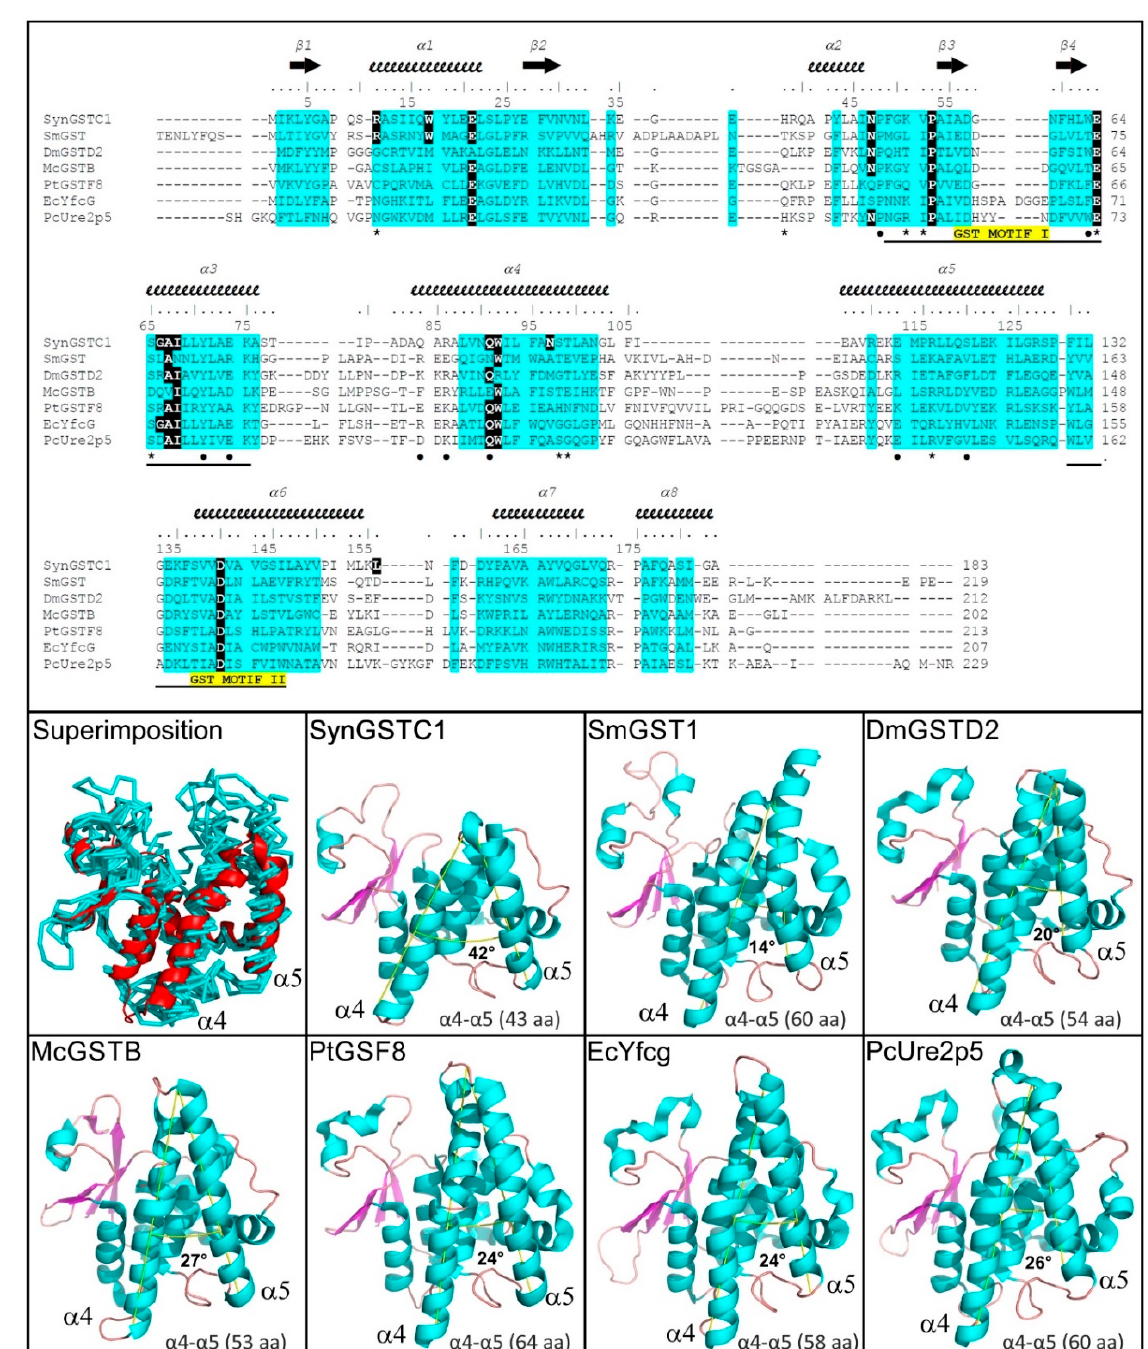
Figure 2. Comparison of SynGSTC1 with structural homologs. The top figure shows a structure-based sequence alignment, and the bottom figures highlight that SynGSTC1 has the shortest α 4– α 5 hairpin and the highest angle between α 4 and α 5 helices. Crystal structure and sequences can be found at the Protein Data Bank (http://www.rcsb.org, accessed on 30 September 2022): SynGSTC1, this study, PDB ENTRY 8AI8; SmGST, GST from Sinorhizobium meliloti 2011, PDB entry 4NHW; DmGSTD2, GST delta